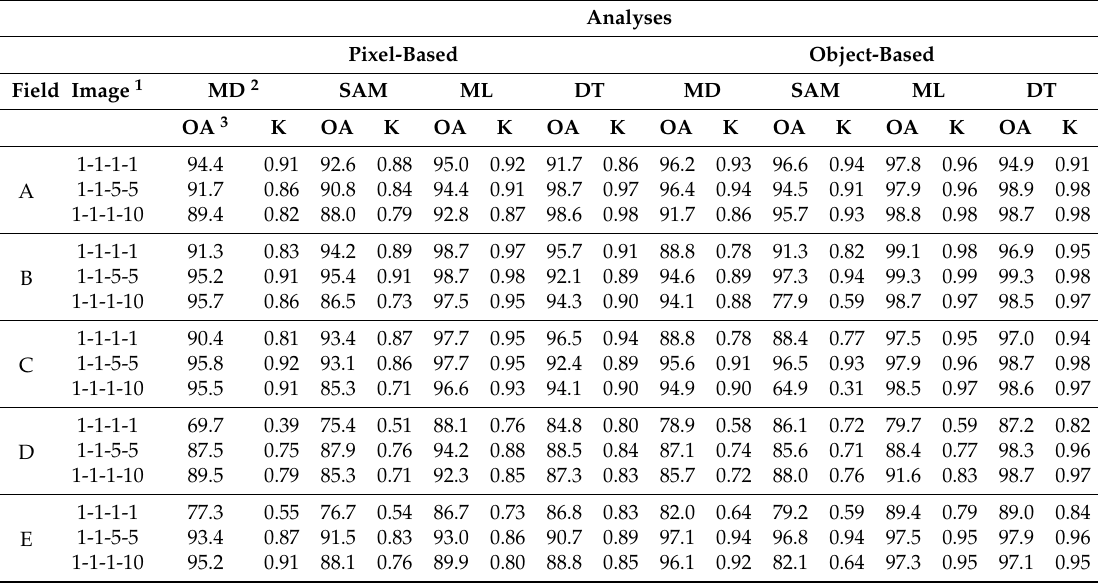
Table 4. Classification accuracies of olive orchards at the five fields analysed in the three pansharpened images using different classification algorithms.